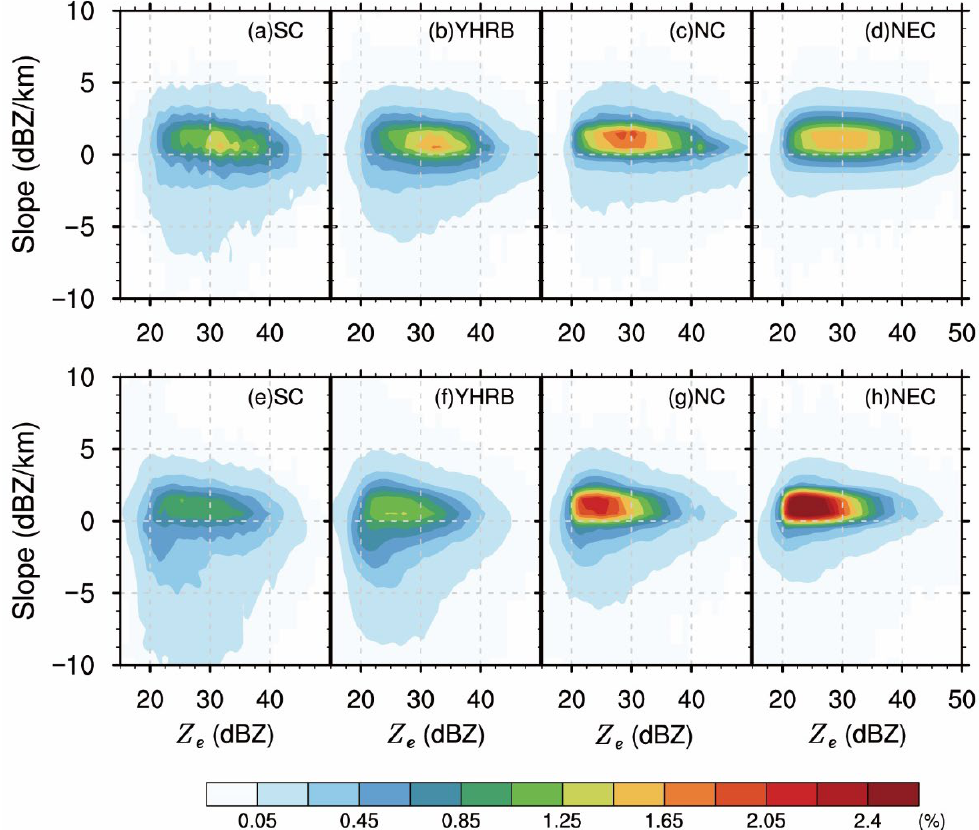
Figure 3. Frequency pattern in two-dimensional space of the slope of Z e from 1 km to 3 km below the LH and Z e at 2 km above the MSL over ( a , e ) SC, ( b , f ) YHRB, ( c , g ) NC and ( d , h ) NEC for the LPFs (upper panel) and NLPFs (lower panel) during summer in the time period 2014–2021.